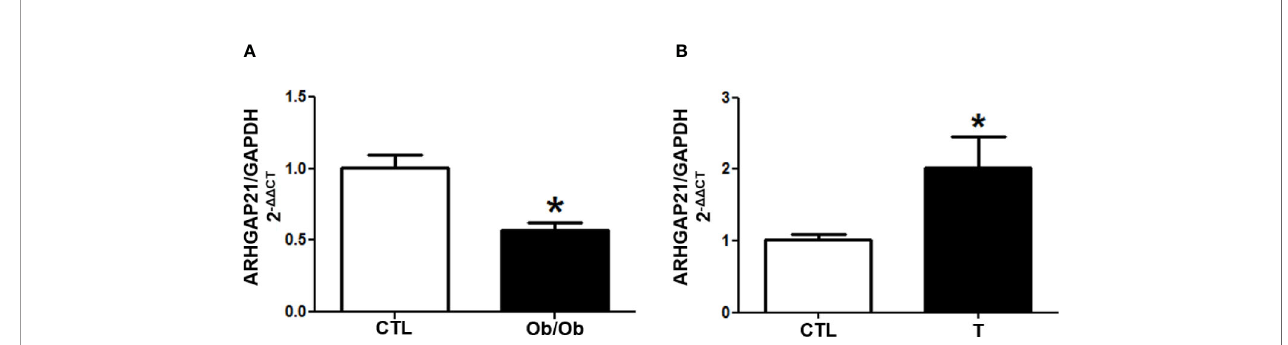
FIGURE 1 | ARHGAP21 expression in islet from hyper- and hypo-secreting insulin animal model. ARHGAP21 expression was evaluated by RT-qPCR in islet from (A) B6.V-Lep ob /JUnib mice (Ob/Ob) and (B) endurance-trained mice (T), compared to the CTL group. In islets from Ob/Ob mice ARHGAP21 was reduced by 40%, and 2 times increased in islets from trained mice (n = 3 – 4). Data are presented as the mean ± SEM. *P ≤ 0.05 vs CTL. CTL, control mice; Ob/Ob, B6.V-Lep ob /JUnib mice; T, endurance training; SEM, standard error of the